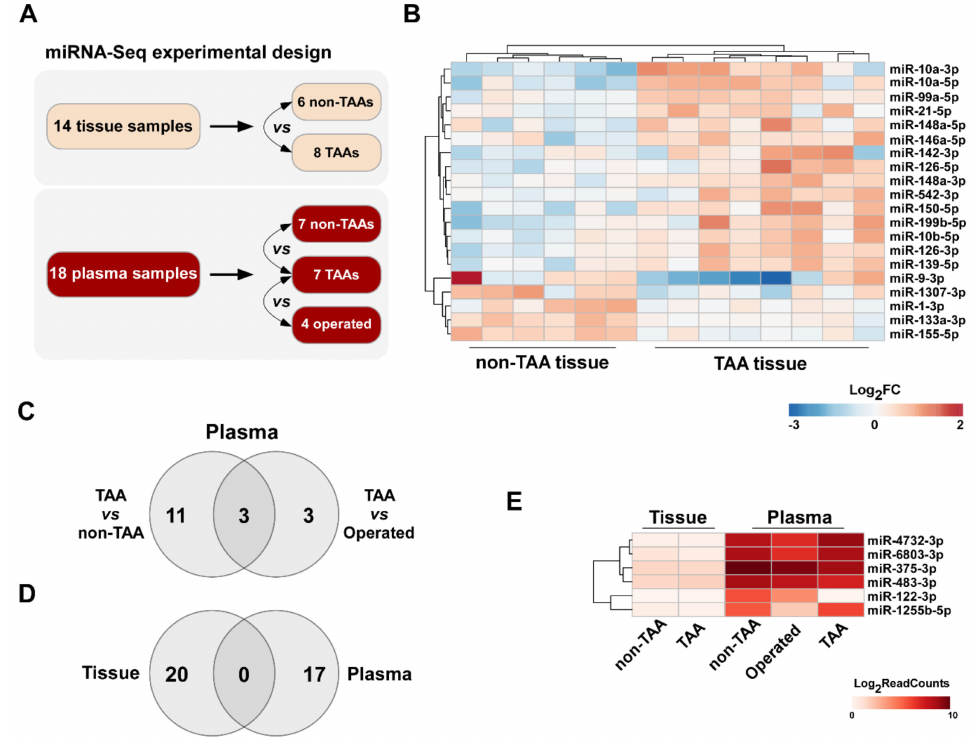
Figure1. DifferentialmiRNAexpressionanalysisinTAAtissueandplasmasamplesusinghigh-throughput RNA sequencing. ( A ) Schematic diagram of miRNA-Seq experiment. ( B ) Heat map showing a total of 20 miRNAs differentially expressed (fold change, FC > 1.5, p < 0.05, normalized read count average, RC > 10) in TAA tissue samples ( n = 8) compared to normal aorta tissue ( n = 6). Red color